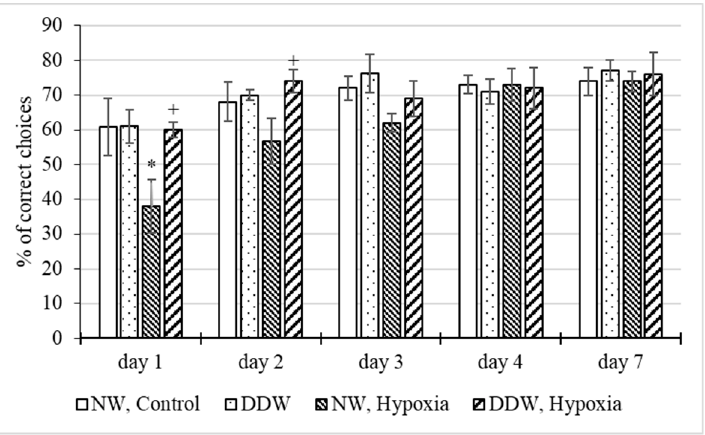
Figure 4. Influence of water with a low deuterium content ( δ 2 H = − 679‰) in the norm and under the influence of hypoxia on the % of correct choices in the “T-maze” test (M ± m). *— p < 0.05 in comparison with the “NW, Control” group, +— p < 0.05—in comparison with the “NW, Hypoxia” group.